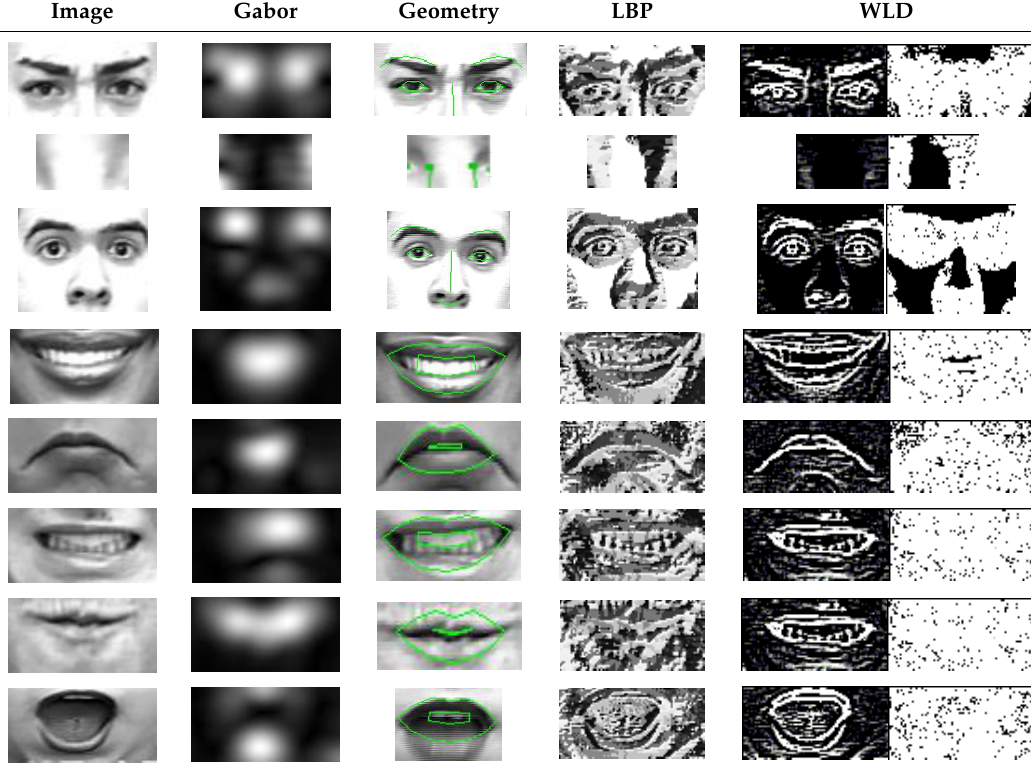
Table 2. Four kinds of feature extraction results for AU blocks.